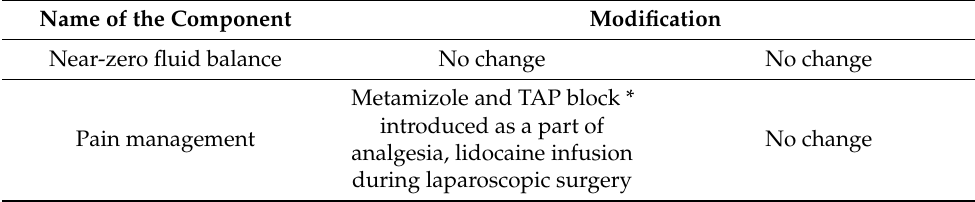
Table 3. Cont. Name of the Component Modification